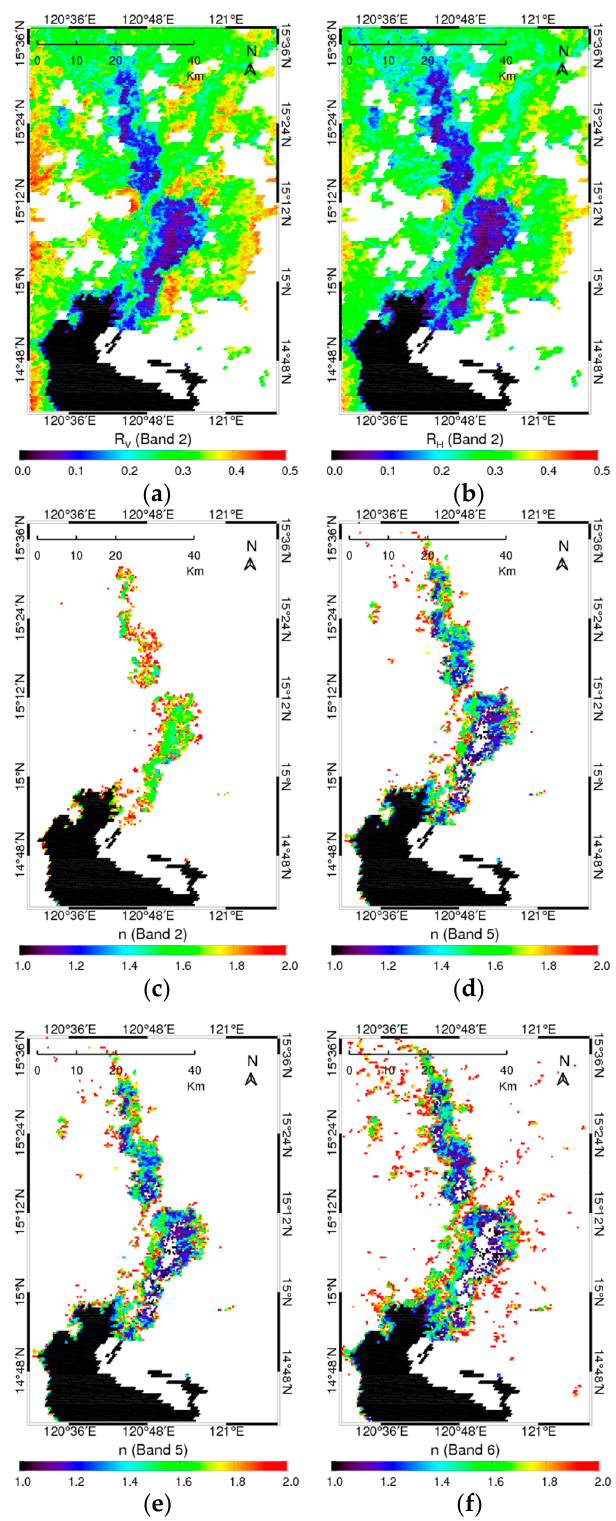
Figure 12. Retrieved V-and H-polarized reflectivities and refractive index over the flood area in the Pampanga River at band 2 using the Hong and ASH approximations. ( a ) R V , ( b ) R H , ( c ) n (ASH), ( d ) n (Hong), ( e ) n (Hong) at band 5, and ( f ) n (Hong) at band 6. Hong and ASH indicate Hong approximation and ASH approximation, respectively.